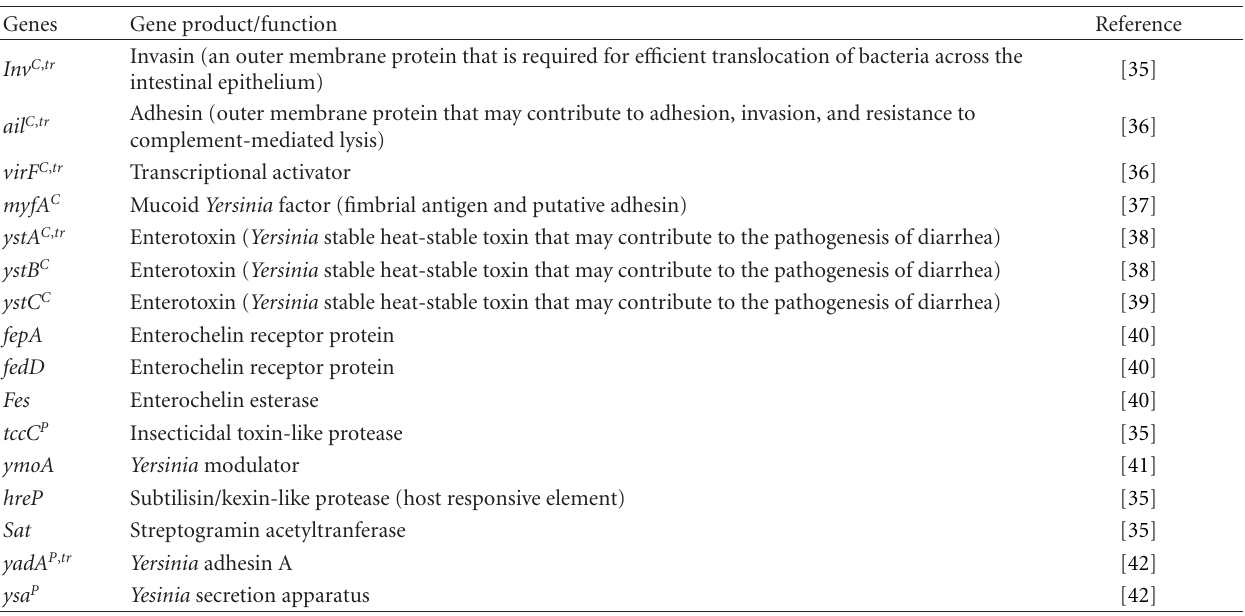
Table 3: Virulence-associated genes in Y.